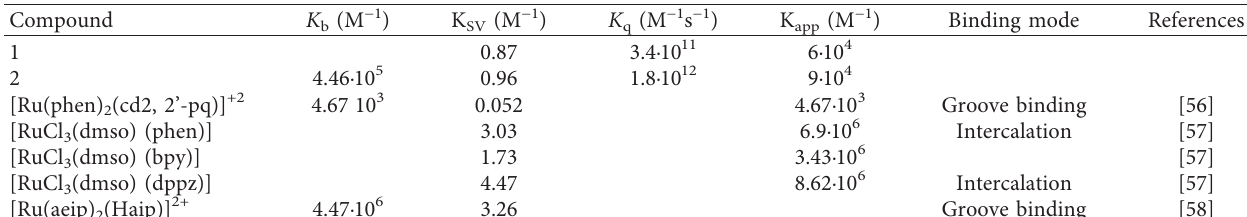
Figure 5: Absorption titration for complex 2 with Table 6: Binding constants and Stern–Volmer quenching constants of Ru (II) complexes at 25 ° C.